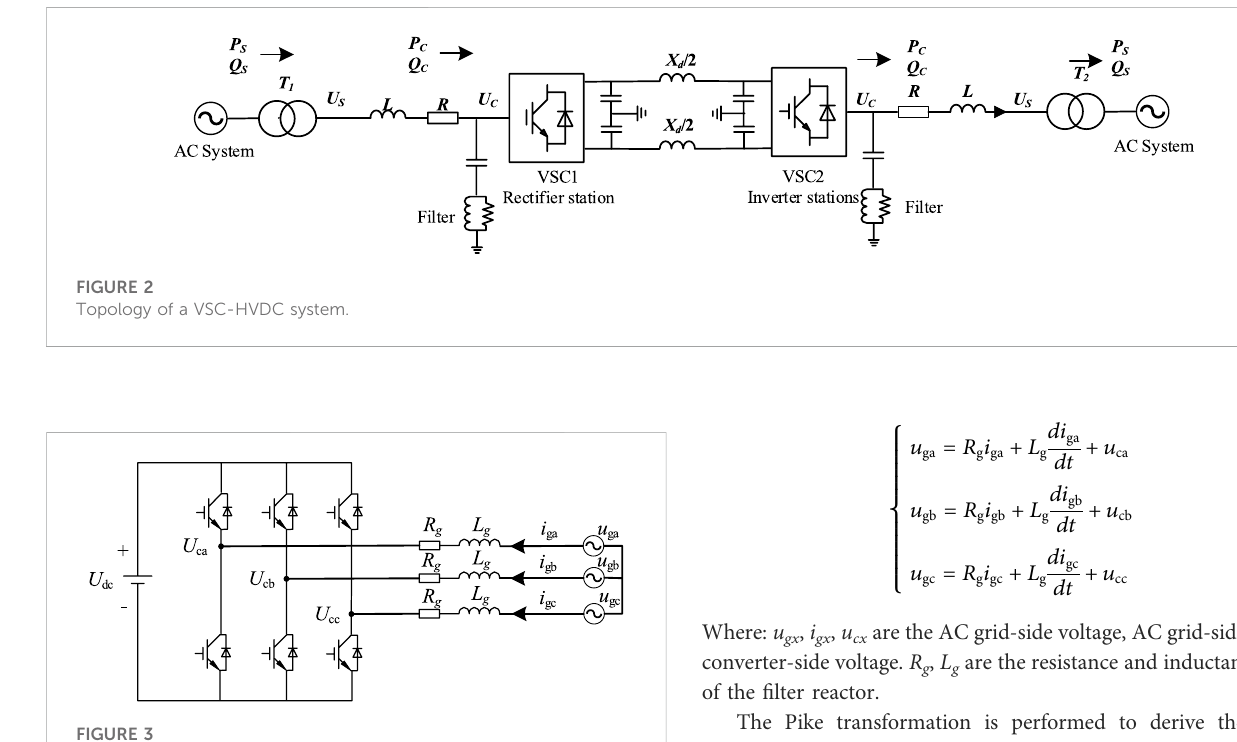
FIGURE 3 Topology of